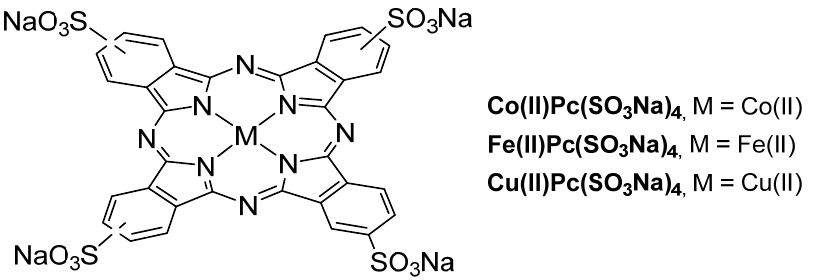
Figure 18. Structure of metallophthalocyanines Co(II)Pc(SO 3 Na) 4 , Fe(II)Pc(SO 3 Na) 4 and Figure Cu(II)Pc(SO 3 Na) 4 used for ethanethiol oxidation. Adapted from [66].